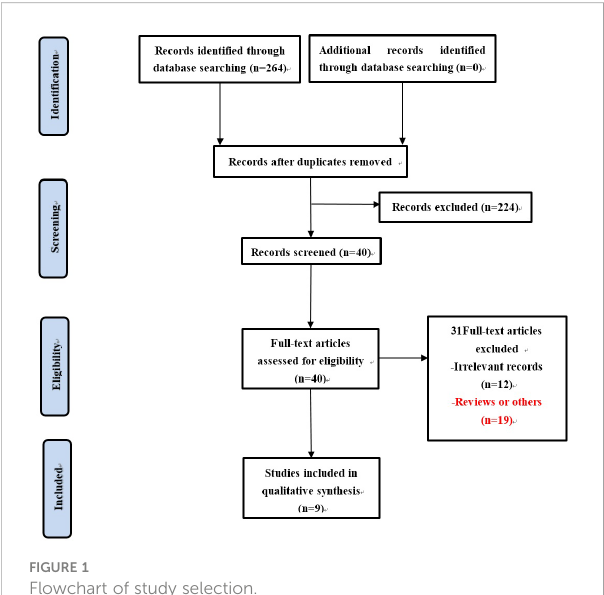
FIGURE 1 Flowchart of study